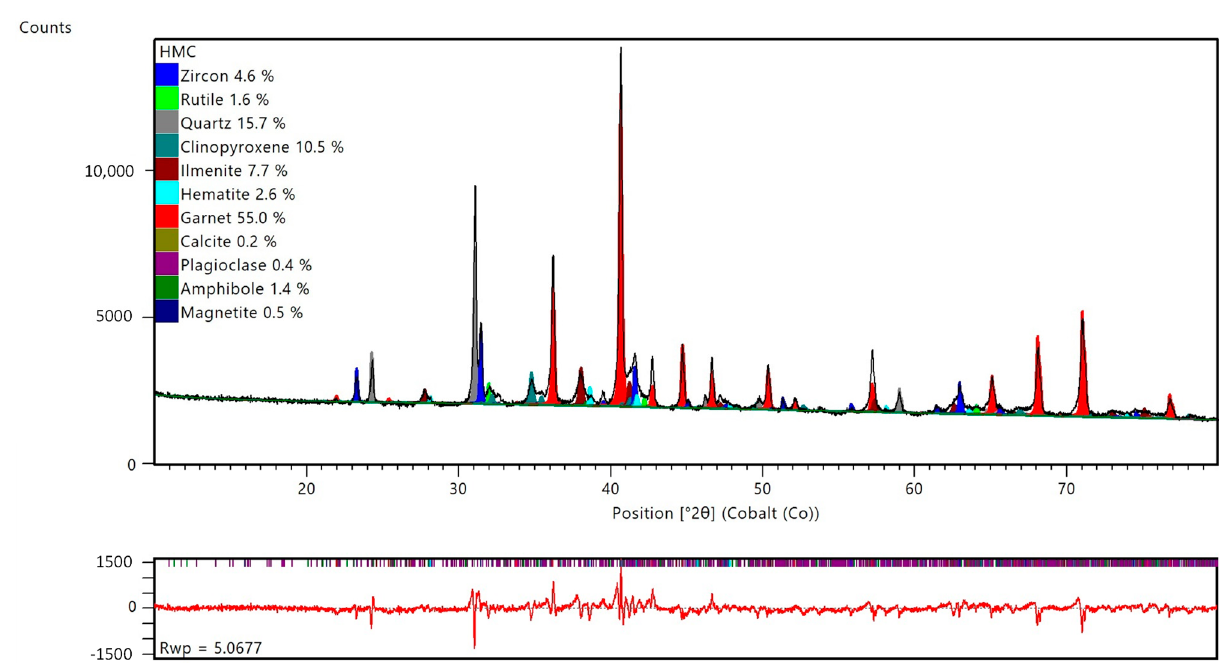
Figure 5. Typical Heavy Mineral Concentrate (HMC). Rietveld quantification ( top ) including the difference plot between measured and calculated profiles, as well as the R wp ( bottom ).